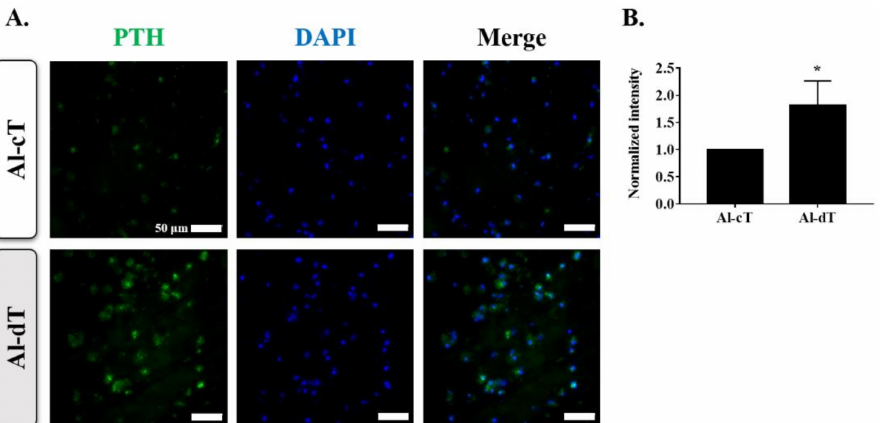
Figure 3. Immunofluorescence analysis of alginate microbeads. ( A ) Representative images of two groups showing PTH (green) and DAPI (blue). ( B ) Quantitative analysis of PTH intensity normalized to nuclear fluorescence. The results are representative of at least three independent experimental repeats. Bars indicate the mean ± S.D. Statistically significant difference is denoted as * p <